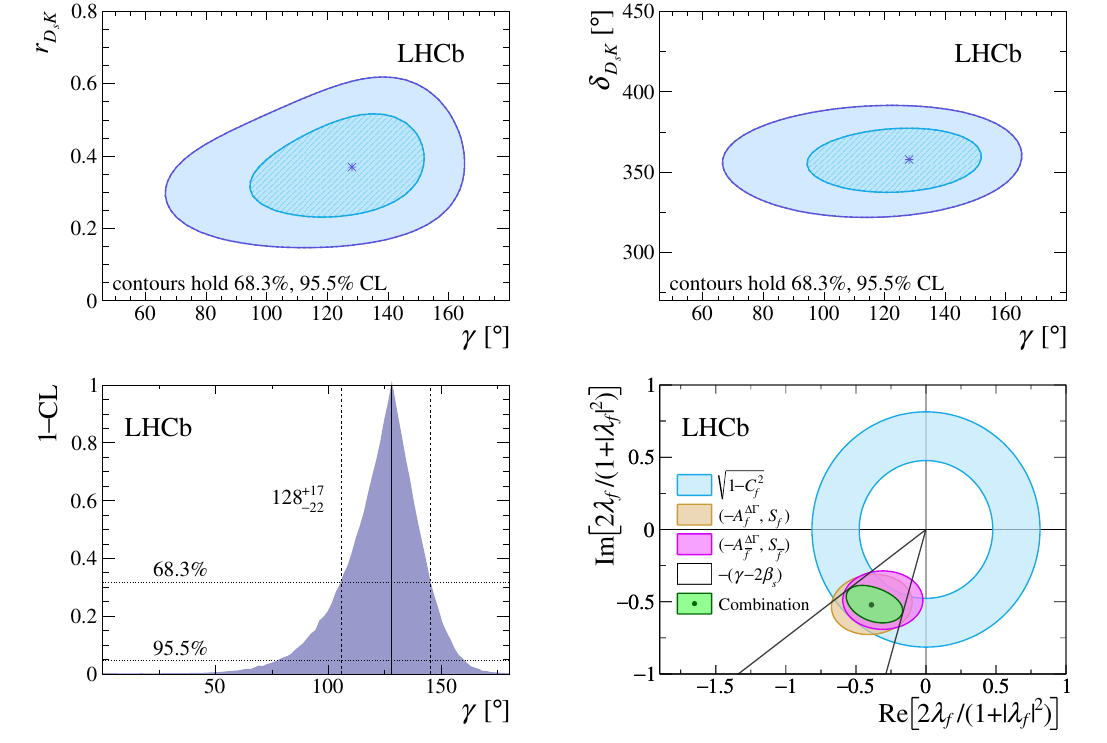
Figure 7 . Pro(cid:12)le likelihood contours of (top left) r D vs. (cid:13) , and (top right) (cid:14) vs. (cid:13) . The markers s K denote the best-(cid:12)t values. The contours correspond to 68.3% CL (95.5% CL). The graph on the bottom left shows 1 CL for the angle (cid:13) , together with the central value and the 68.3% CL interval (cid:0) as obtained from the frequentist method described in the text. The bottom right plot shows a visualisation of how each of the amplitude coe(cid:14)cients contributes towards the overall constraint on the weak phase, (cid:13) 2 (cid:12) s . The di(cid:11)erence between the phase of ( A (cid:1)(cid:0) ; S f ) and ( A (cid:1)(cid:0) (cid:22) ; S (cid:22) ) is f f f (cid:0) (cid:0) (cid:0) proportional to the strong phase (cid:14) , which is close to 360 (cid:14) and thus not indicated in the